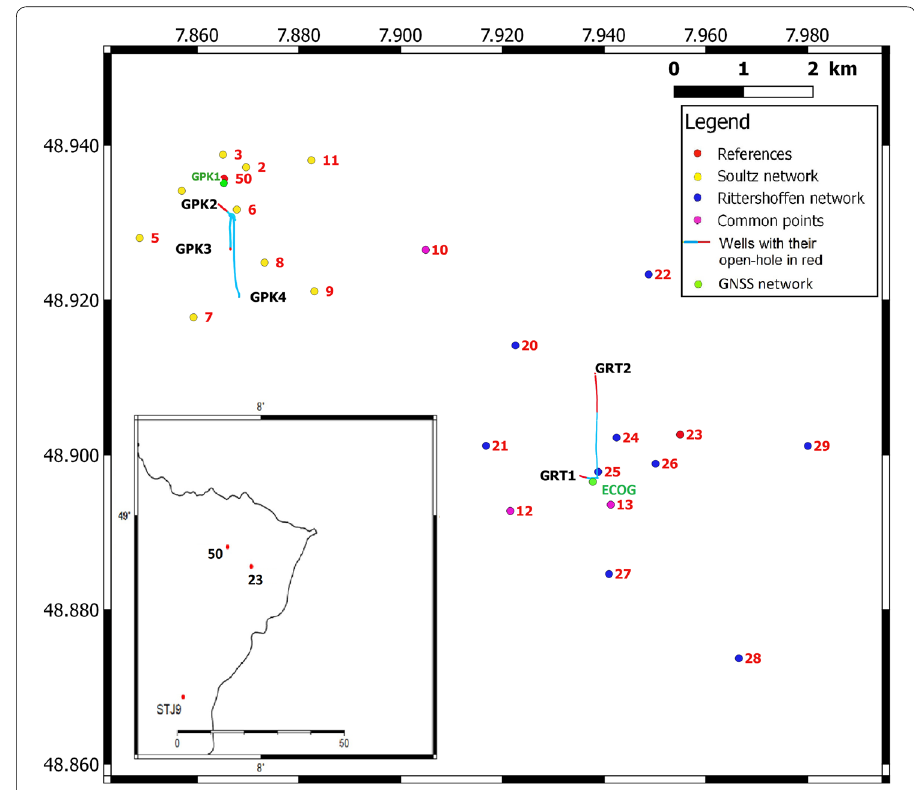
Fig. 2 The Soultz‑sous‑Forêts (yellow circles) and Rittershoffen (blue circles) gravity networks. The station codes are written in red. In particular, the stations 50 and 23 (red circles) are, respectively, the reference sta‑ tion of the Soultz‑sous‑Forêts and Rittershoffen networks. The two continuous GNSS stations are indicated in green. The projection of GRT1, GPK3, GPK4 injection wells and GRT2 and GPK2 production wells on the surface is represented by a blue line. The red lines are their open‑hole trajectories. STJ9 in the inset indicates the position of the gravity observatory of Strasbourg